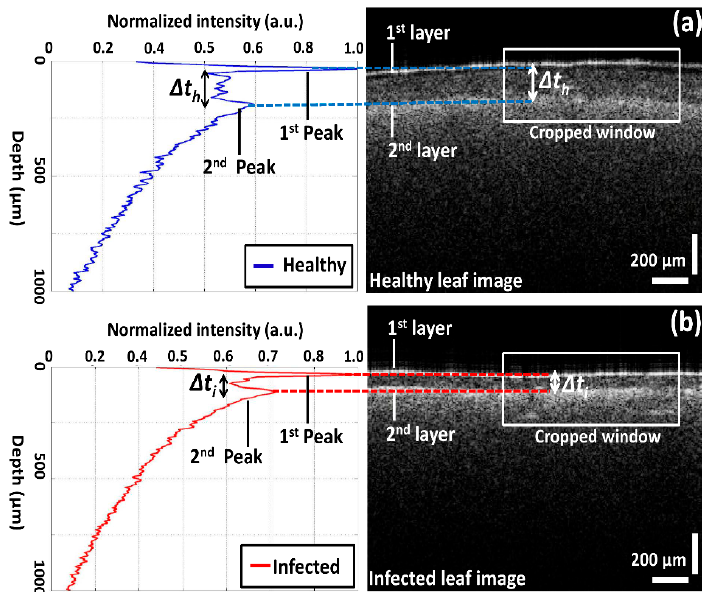
Figure 3. A-scan profiles of healthy and infected leaves and corresponding layer information: ( a ) healthy leaf; ( b ) infected leaf. White square region depicts the selected cropped window for averaging 200 intensity signals.